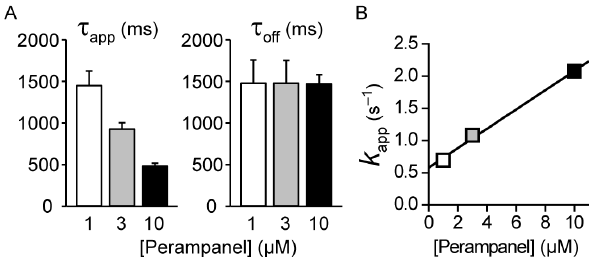
Figure 4. Kinetics of peramapanel block of AMPA-evoked currents. (A) Time constants for block and unblock of 100 m M AMPA- evoked currents determined from the best single exponential fits to current traces at the onset ( t app ) and termination ( t off ) of application of 1, 3 and 10 m M perampanel. (B) Reciprocal mean t app values (= k app ) plotted against perampanel concentration. The best-fit straight line to the data is shown. The slope and the intercept values are 1.5 6 0.1 6 10 5 M 2 1 s 2 1 and 0.58 6 0.6 s 2 1 , respectively.